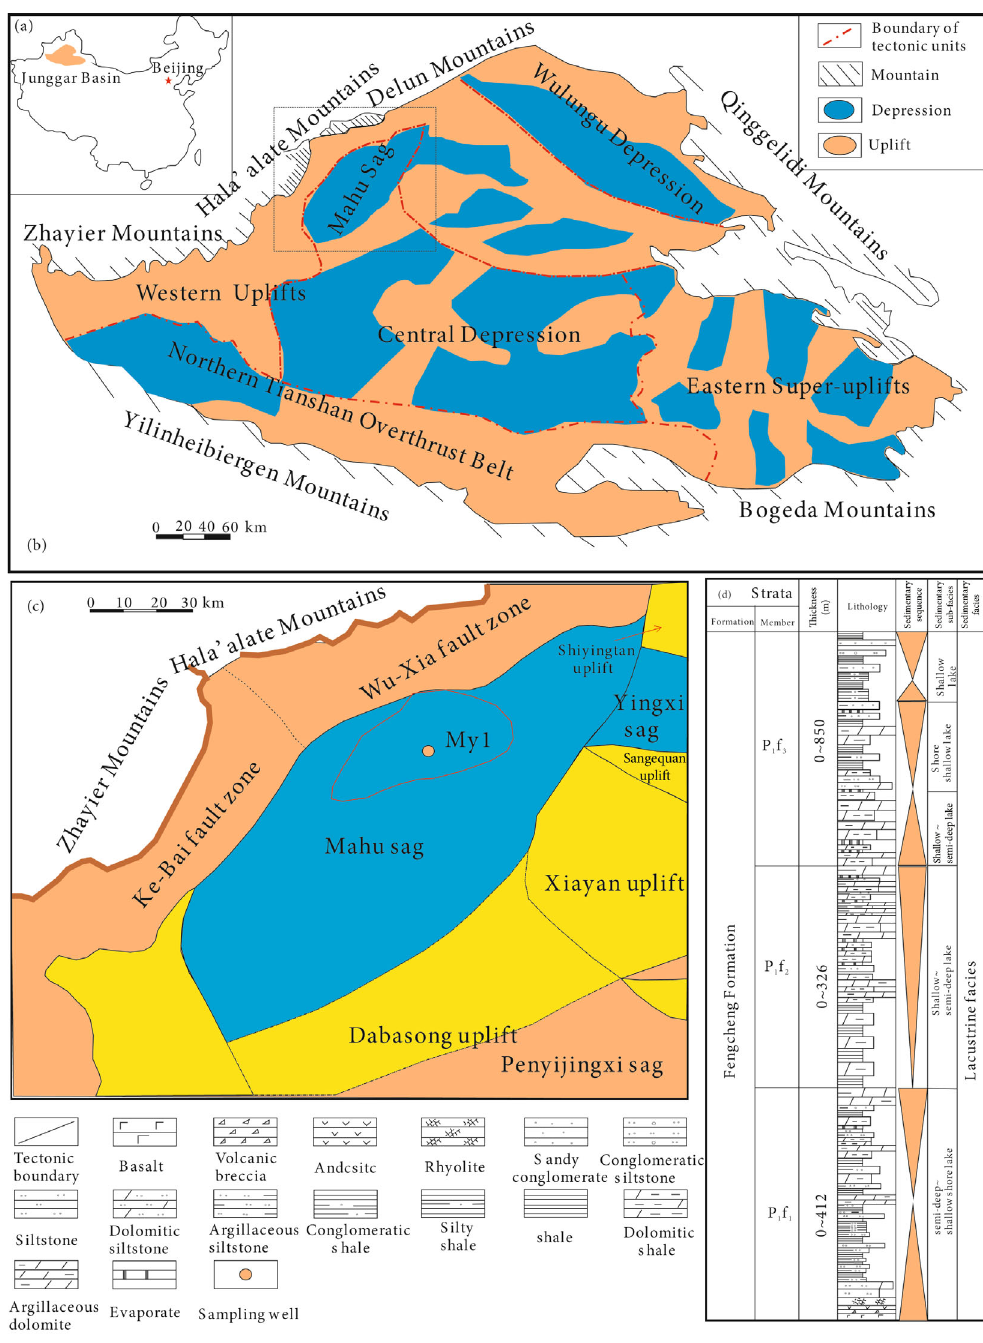
Figure 1: (a) Map of the Junggar Basin in China. (b) The division of tectonic units in the Junggar Basin and the location of the Mahu scheme. (c) The division of subtectonic units and thickness contour of Fengcheng Formation in Mahu Sag. (d) Lithology and sedimentary facies pro fi le of the Fengcheng Formation in the Mahu Sag